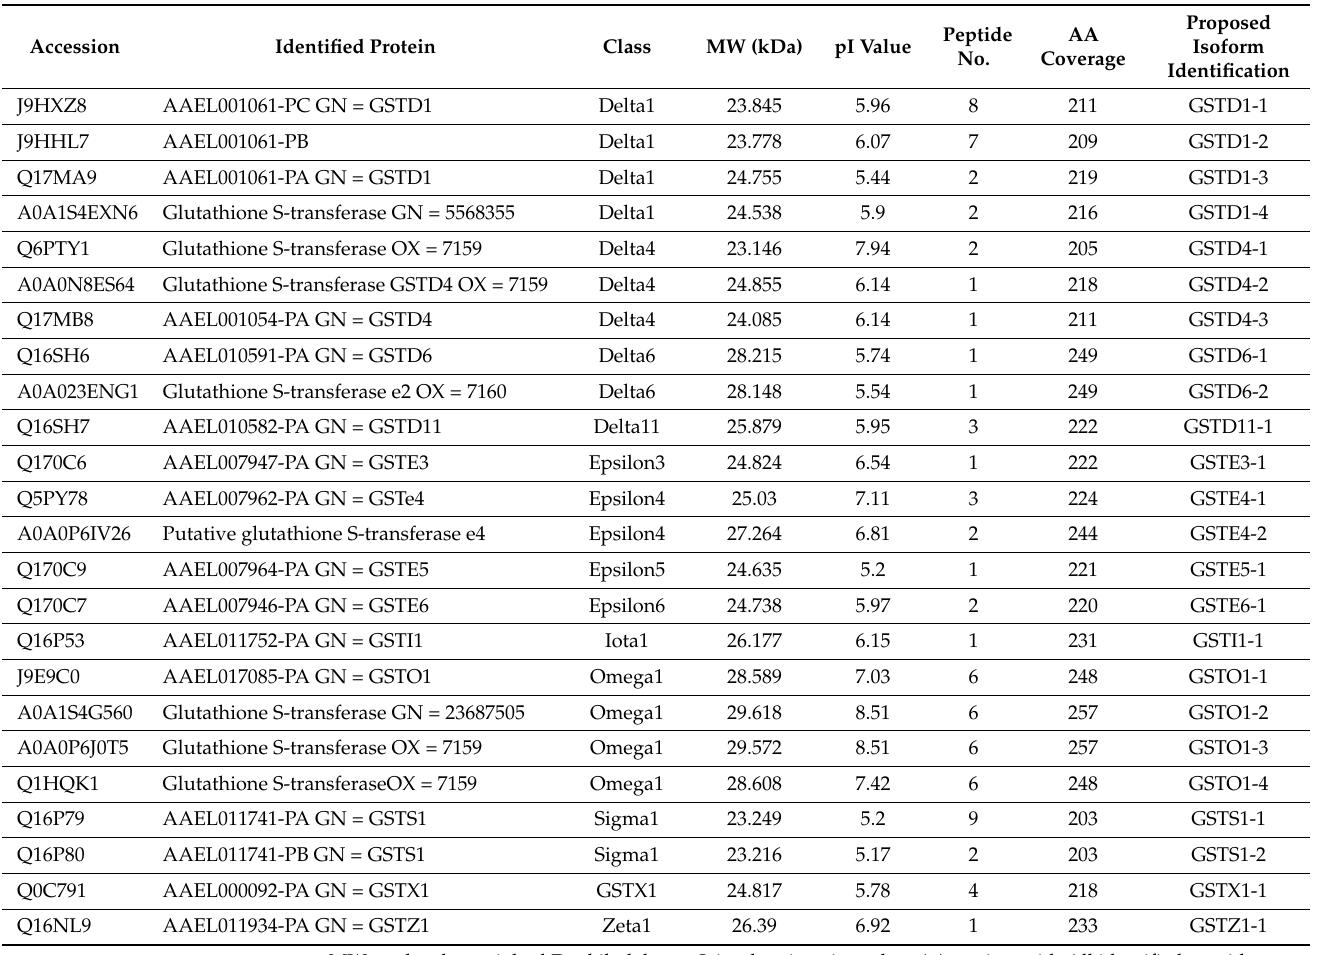
Table 1. In vivo glutathione S-transferase isoforms identified in susceptible, permethrin-treated, and malathion-treated Aedes albopictus